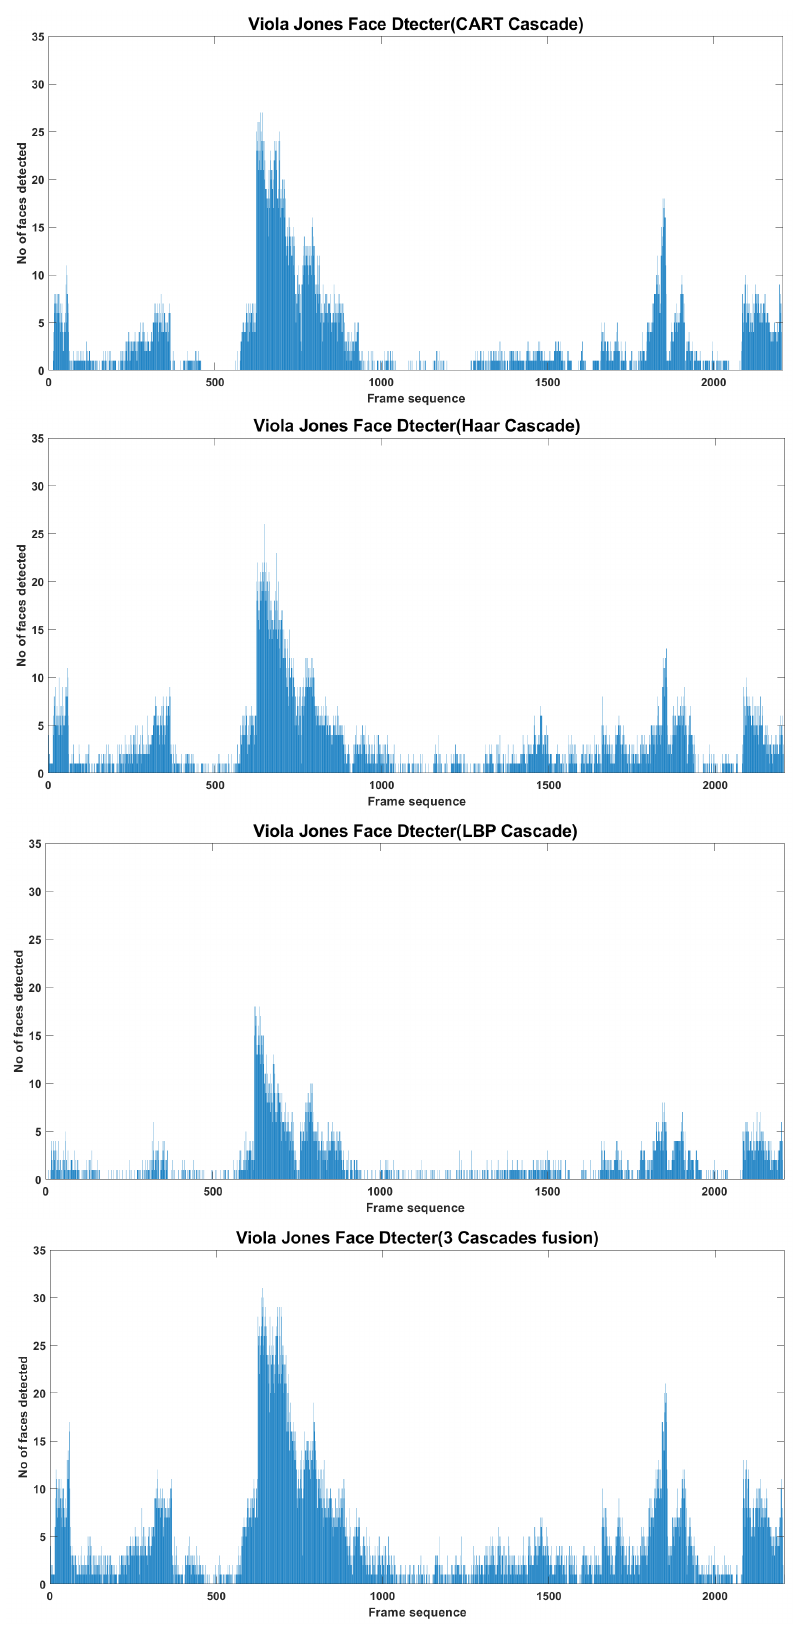
Figure 13. Detected faces counts on individual